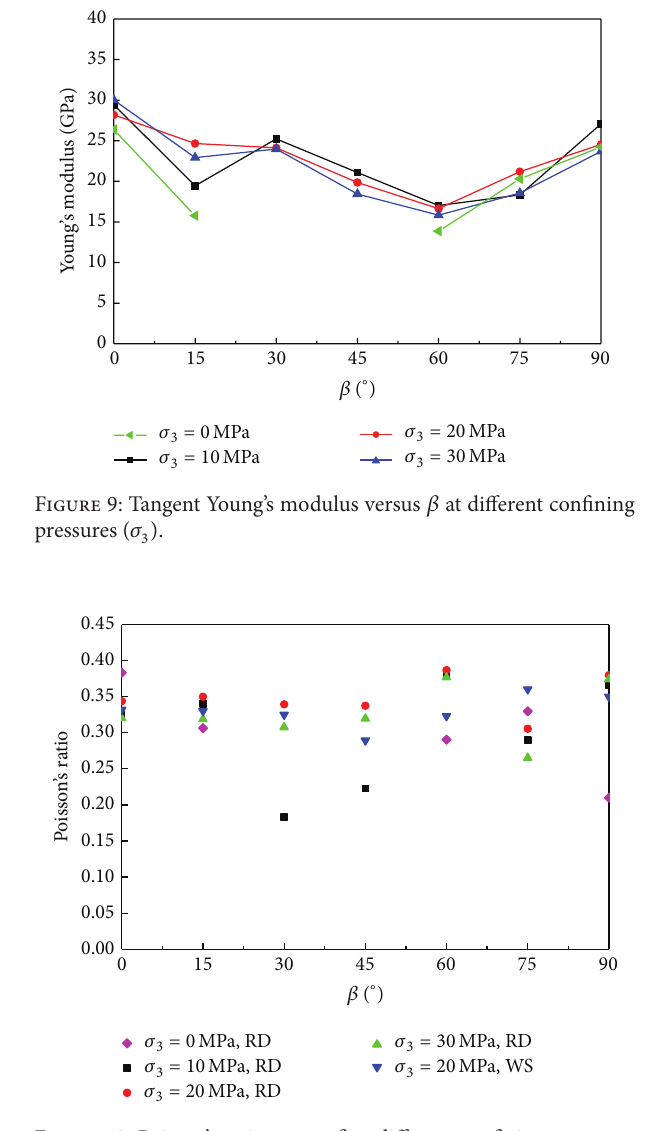
Figure 10: Poisson’s ratio versus 𝛽 at different confining pressures ( 𝜎 3